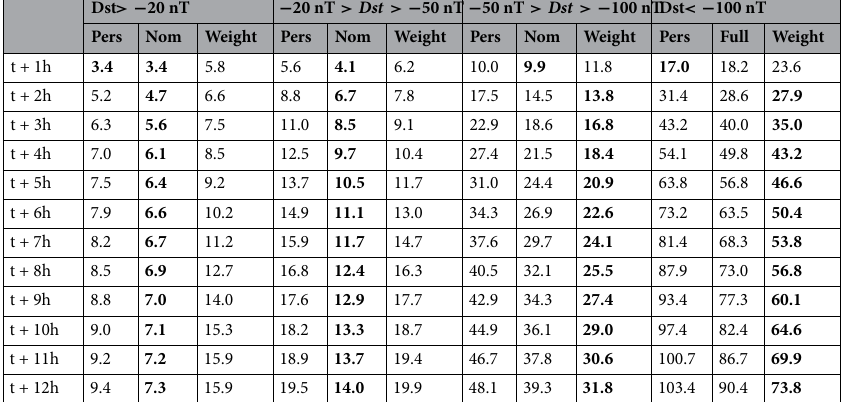
Table 3. Same as Table 2 but exploding the results in the four different classes of geomagnetic activities. The weighted model perform better than the other two in high and intense geomagnetic conditions. Best results are in